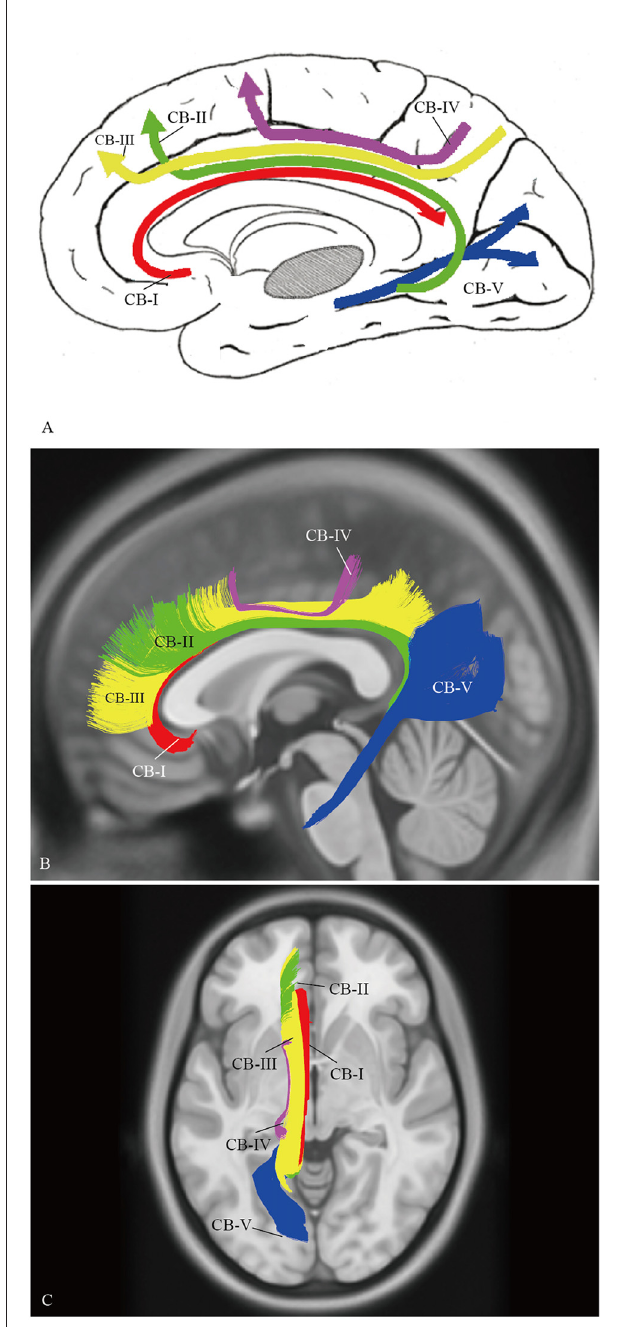
FIGURE 11 | Spatial Relationship of the subcomponents on HCP-488 template. (A) A complete schematic map of the five segments. (B) Depicting five segments of CB on the HCP-488 template T 1 sagittal view. The CB-I snugly curves around the genu of the CC and spreads into the orbital-frontal cortex as the lowest subdivision. For the projective scope in the medial aspect of the SFG, the CB-III is obviously larger than that of the CB-II. The body section of the CB-II extends along the bottom of the CB-III, while the caudal section is slightly more medial than the CB-V, despite their overlaps. (C) Axial view. The CB-I is closest to the midline in all the segments. The CB-IV is the smallest fiber tract in the CB system. It is situated superficially lateral to the